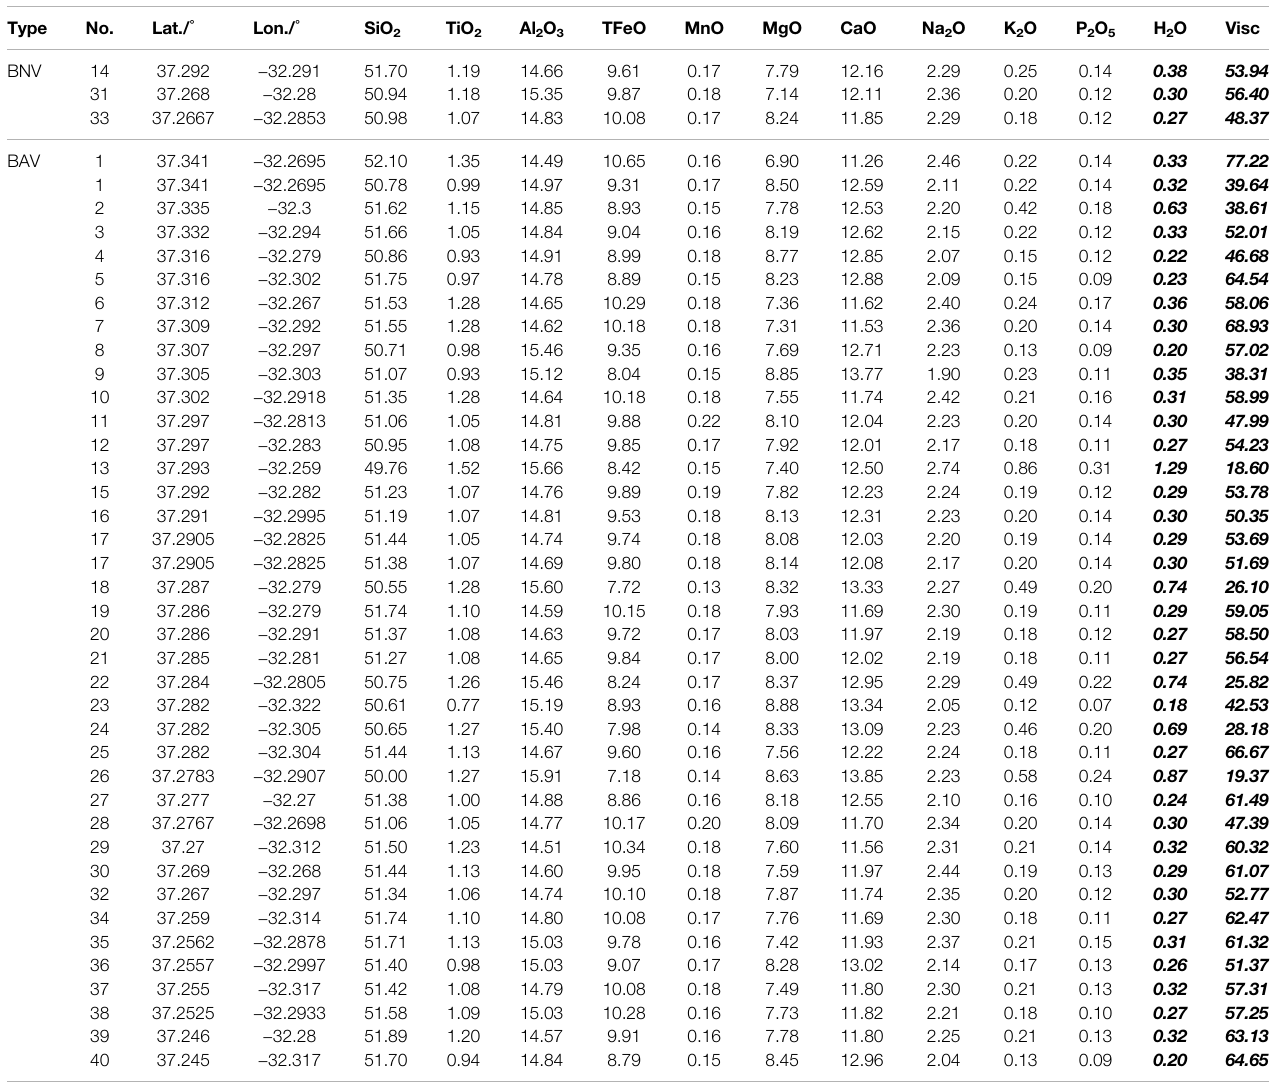
TABLE 6 | Major elements (wt%) and viscosity of basalt (Pa · s) on lucky strike and evan vents (data from PetDB). Type